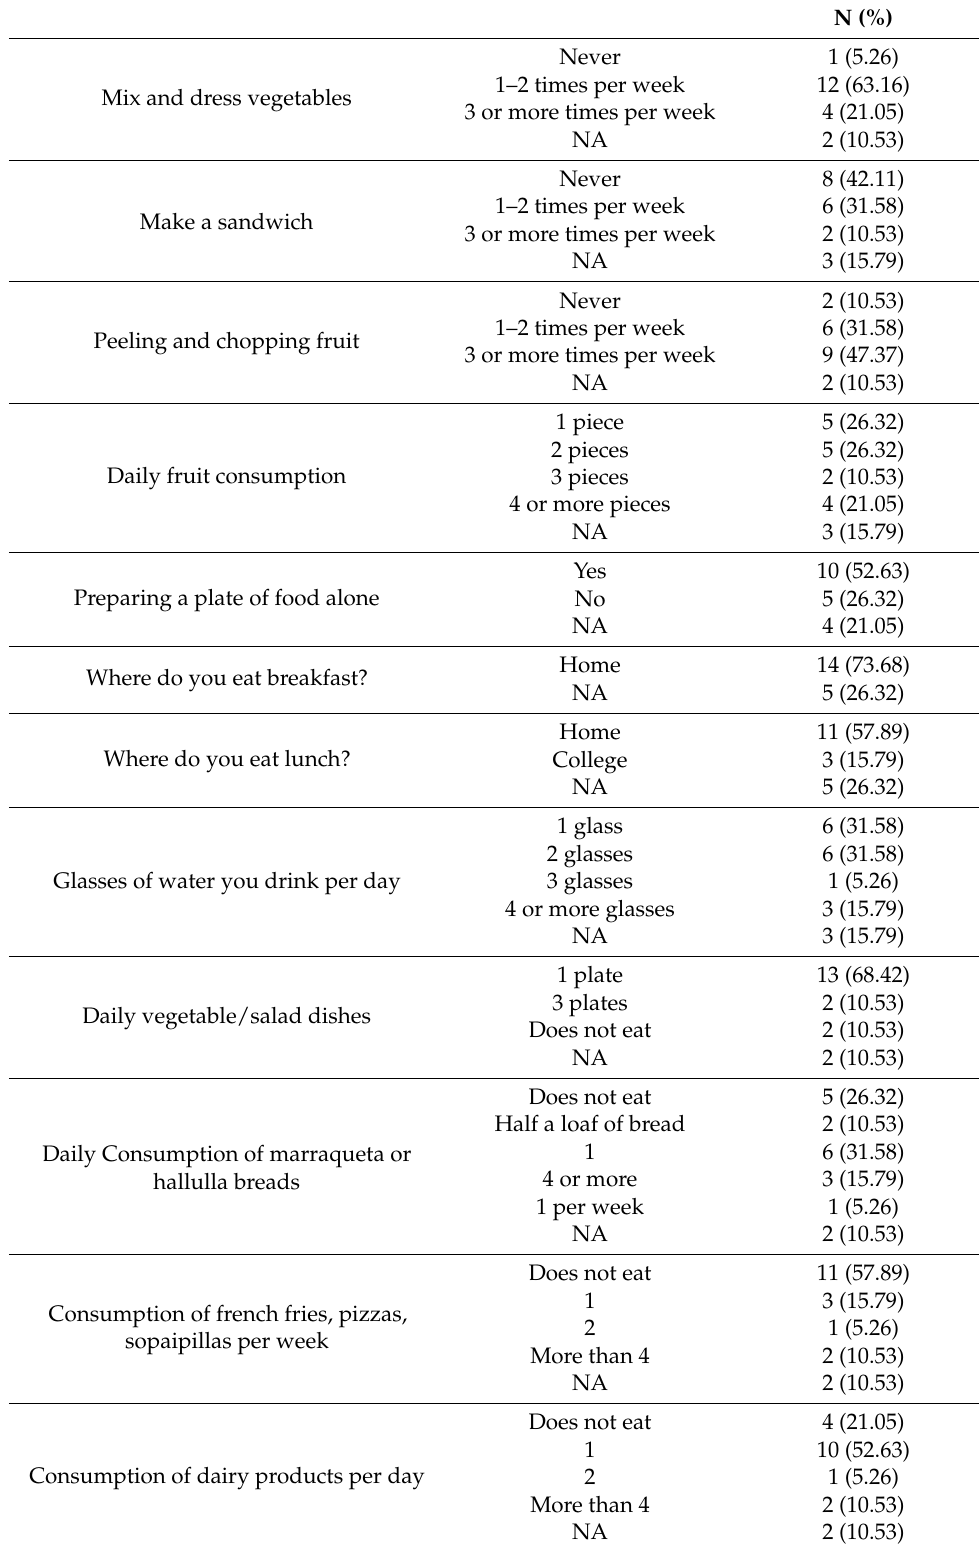
Table 4. Dietary patterns in the child population in the